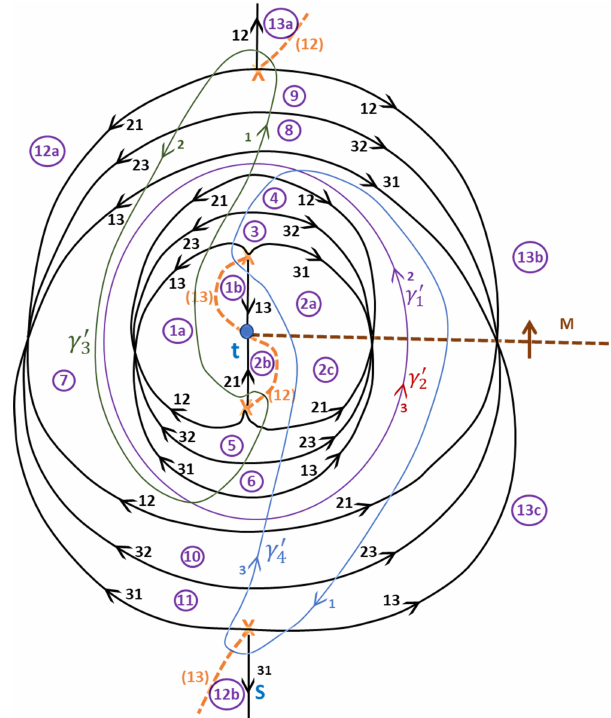
Figure 5 . The Stokes graph at θ = 0 , with u 1 = 4 . 5 , u 2 = 0 and Λ = 1 . The notation conven- tions are the same as those in figure 4. We show representative cycles corresponding to the basis charges γ 0 , γ 0 , γ 0 and γ 0 in purple, red, green and blue respectively. This Stokes graph divides the 1 2 3 4 punctured-plane into 13